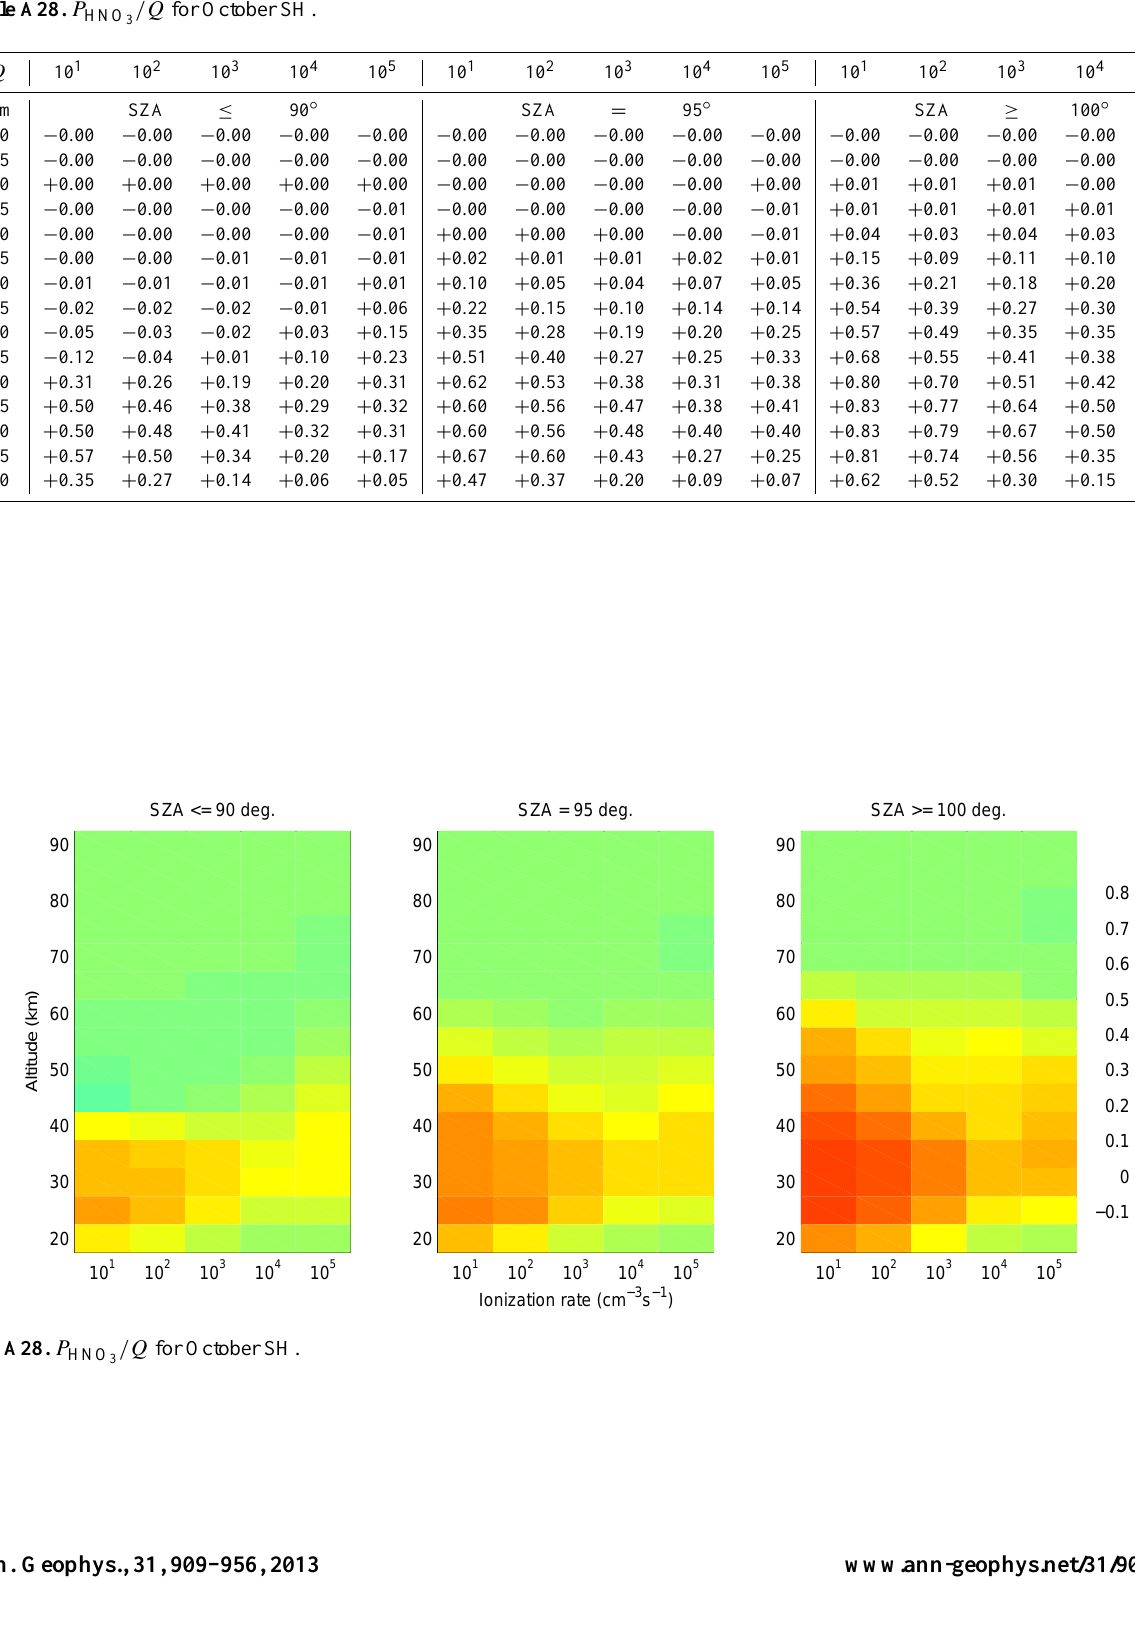
Table A28. P HNO